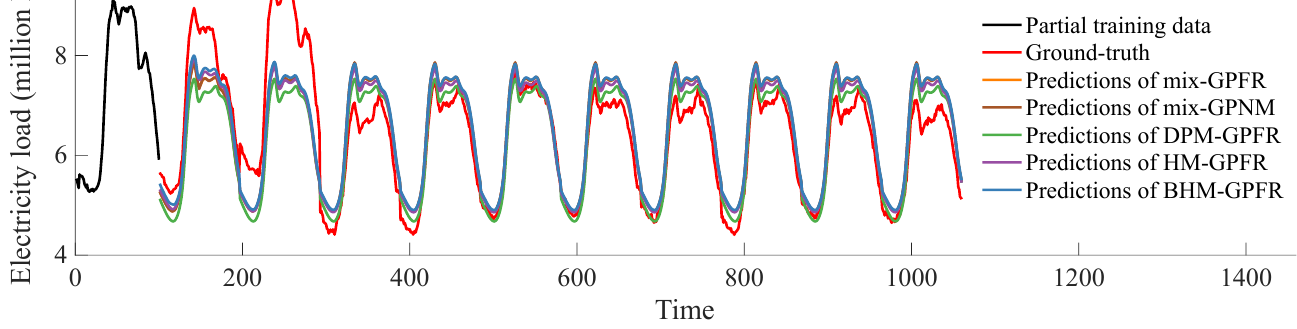
Figure 6. Multi-step prediction results of mix-GPFR, mix-GPNM, DPM-GPFR, HM-GPFR, and BHM-